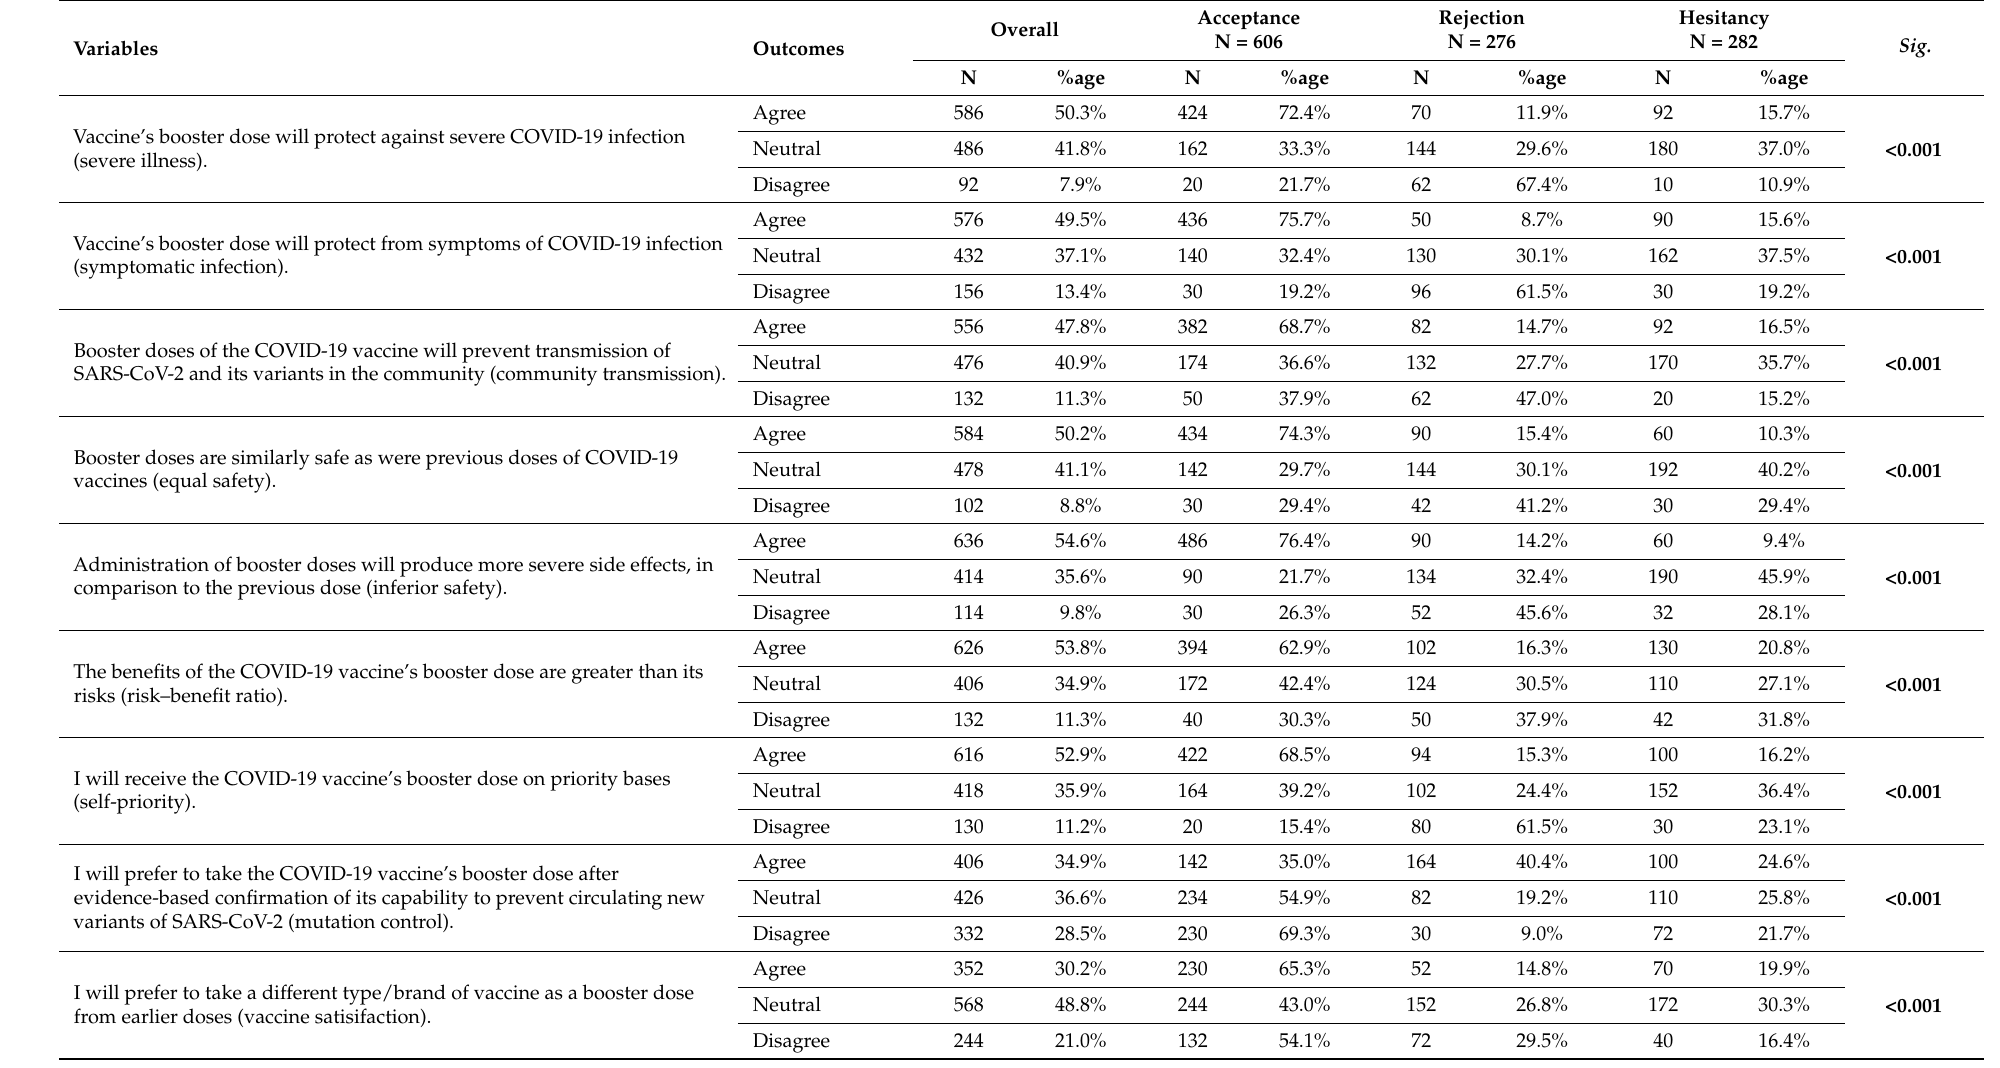
Table 5. The association of psychological determinants of COVID-19 vaccine booster dose with vaccination attitudes of